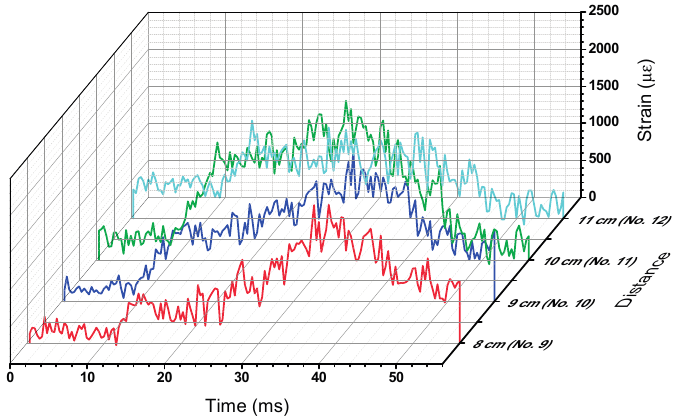
Figure 7. Distributed measurements of a dynamic test for the fiber strands No. 9, 10, 11, 12.